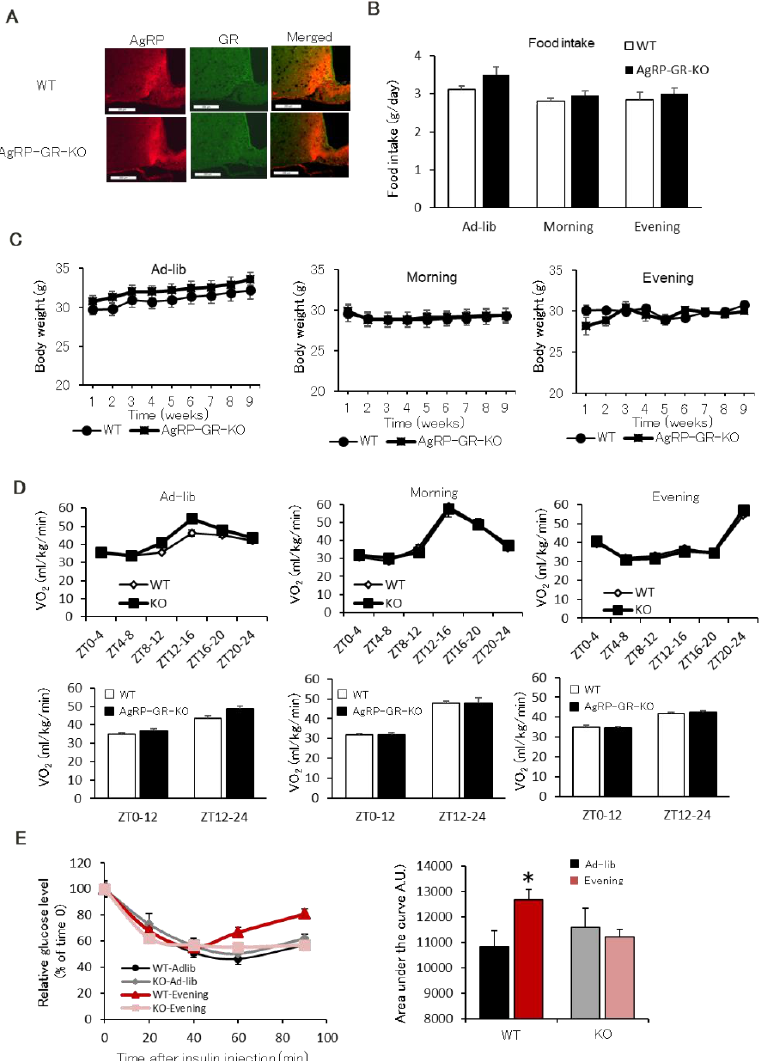
Figure 6. AgRP neuron-specific GR deficient mice has no insulin tolerance even in the Evening feeding schedule. ( A ) Immunohistochemistry of the hypothalamic arcuate nucleus in WT and AgRP-GR-KO mice. The scale bars indicate 100 μ m. ( B ) Food intake in WT and AgRP-GR-KO mice. ( C ) Alteration of body weight in WT and AgRP-GR-KO mice. ( D ) Circadian change of oxygen consumption in WT and AgRP-GR-KO mice. White column shows light period, black column shows dark period of VO 2 in bottom panels. ( E ) Insulin tolerance in Evening group WT and AgRP-GR-KO mice ( n = 6). * p < 0.05 vs. Ad-lib group.